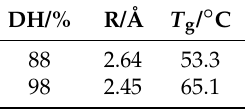
Figure 9. Change in cavity radius and T g of vacuum-dried PVA films upon increasing the degree of hydrolysis from 88% to 98%. Table 4. Comparison of the cavity radius and T g in vacuum-dried films with degrees of hydrolysis PVA-50-88 and PVA-50-98.